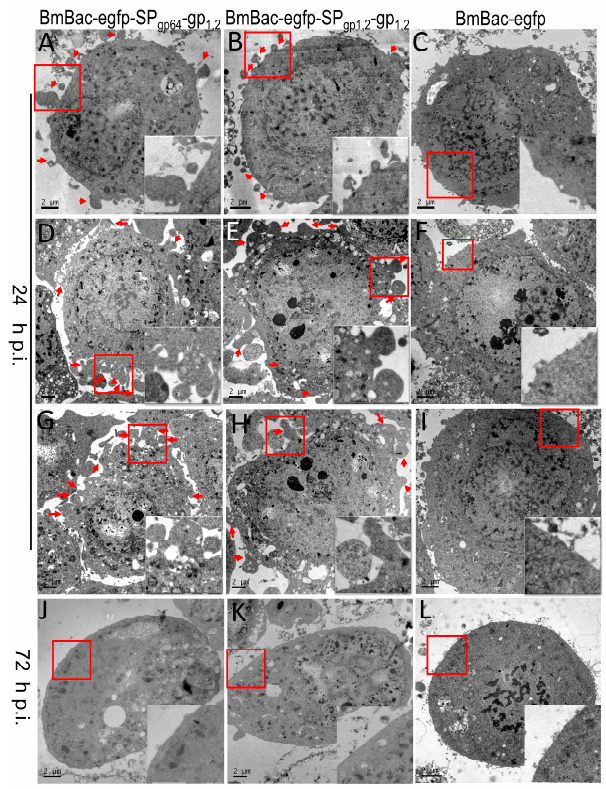
Figure 4. Morphological study by TEM. BmN cells infected with, BmBac-egfp-SP gp1,2 -gp 1,2 ( A , D , G , J ), BmBac-egfp-SP gp1,2 -gp 1,2 ( B , E , H , K ), and BmBac-egfp ( C , F , I , L ) at 24 h p.i. and 72 h p.i. Arrows show